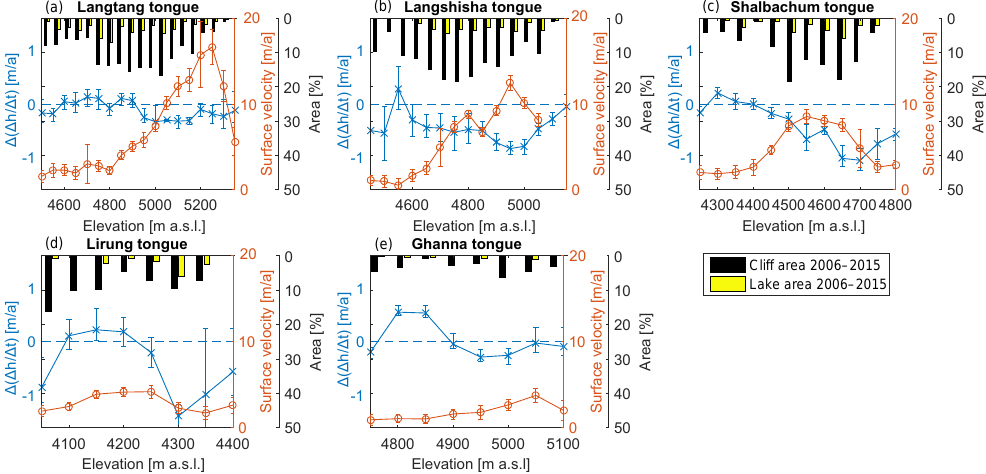
Figure 11. Altitudinal distribution of cliff and lake area fractions, glacier velocity and changes in thinning rates. Cliff and lake area is shown as % of 30m pixels containing cliffs/lakes per 50m elevation band, whereas the values represent the median of six available cliff and lake maps from the period 2006–2015. Glacier velocities (ma − 1 ) represent the median per 50m elevation band of data shown in Fig. 13 and error bars represent the standard deviation in pixel values per elevation band. Changes in thinning rates ( (cid:49) ( (cid:49)h/(cid:49)t ) [ma − 1 ]) are calculated comparing 1974–2006 and the 2006–2015 ensemble mean. Negative (cid:49) ( (cid:49)h/(cid:49)t ) values represent thinning accelerations. Error bars represent the maximum variations in (cid:49) ( (cid:49)h/(cid:49)t ) considering all individual periods within the 2006–2015 ensemble.